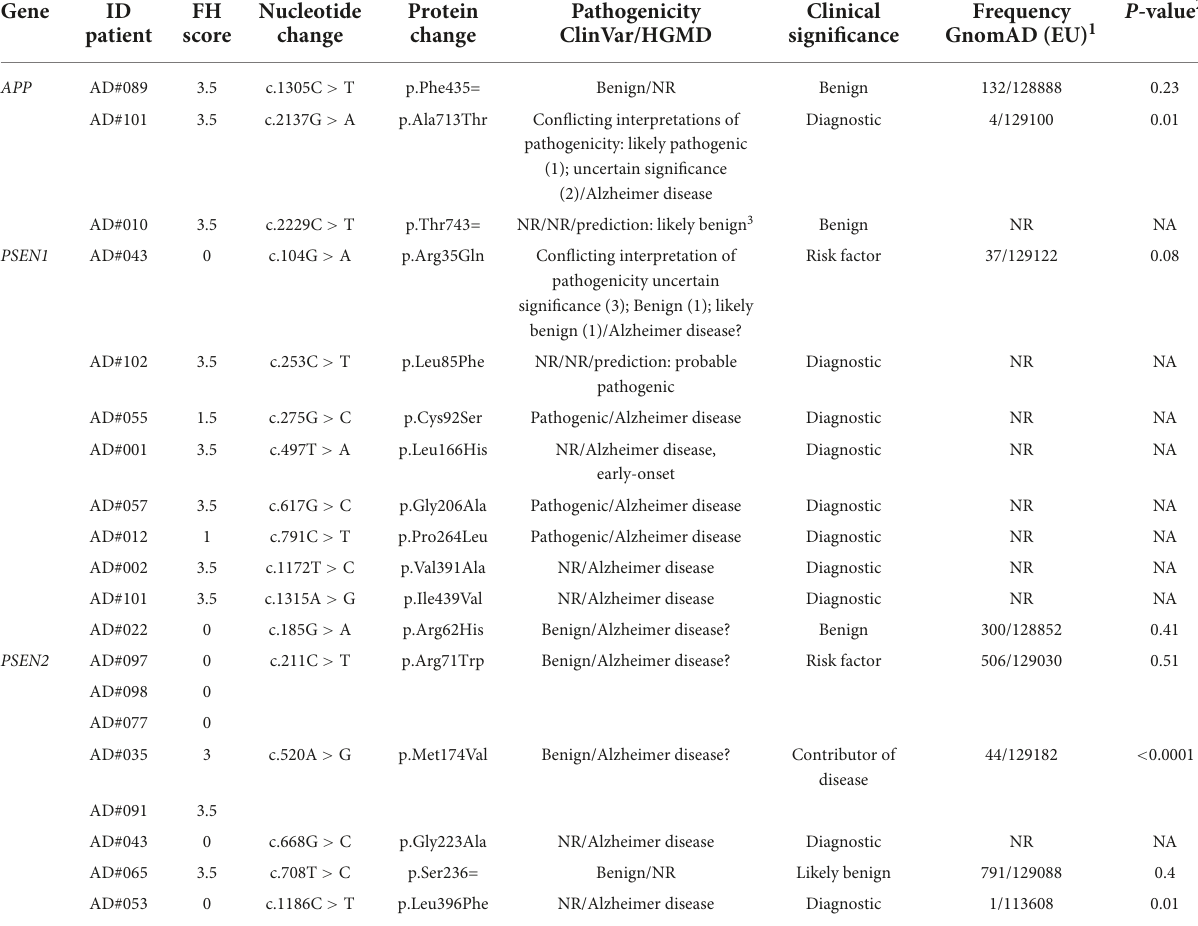
TABLE 2 Rare variants in AD-causative genes identified in this study.